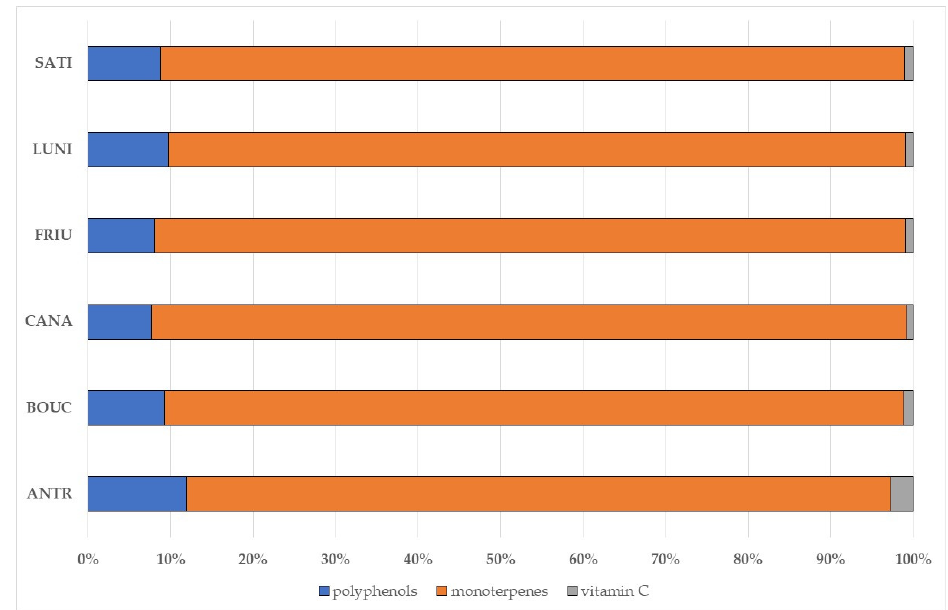
Figure 3. Representation of the phytocomplex of the analysed flours. Different colours identify each chemical class. Blue: polyphenols; orange: monoterpenes; grey: vitamin C. In the phenolic class, differences were identified among flours derived from different chestnut genotypes, but most of the samples showed similar phenolic levels. Benzoic acids and cinnamic acids (expressed as phenolic acids), and tannins were the most abundant classes in this group (40–50% and 20–30%, respectively), followed by catechins (15–20%), as shown in Figure 4. Flavonols were observed in low levels (<5%). The ANTR sample, a commercial C. sativa (cv Marrone Antrodocano) flour from Lazio, showed a different phe- nolic composition in relation to the other flours (e.g., high levels of cinnamic acids and flavonols and low quantities of benzoic acids and catechins).